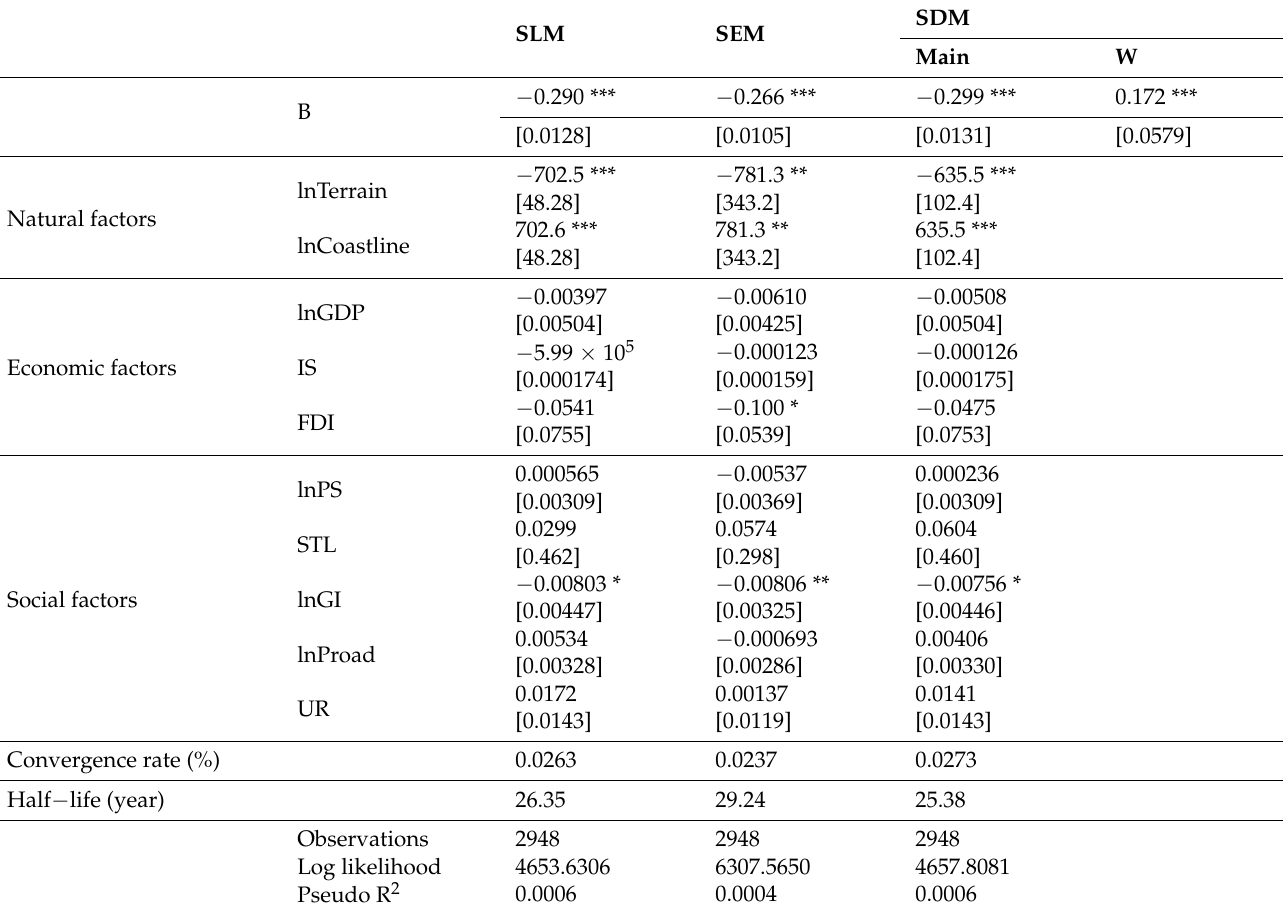
Table 5. Results of spatial econometric